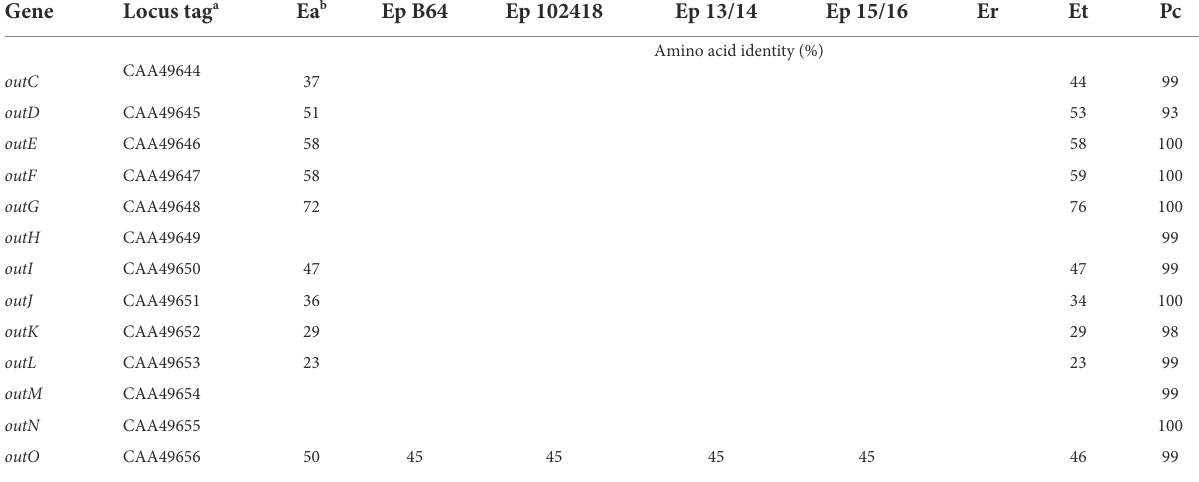
TABLE 5 Absence of the out cluster from the Type II secretion system in Erwinia persicina strains. Gene Locus tag